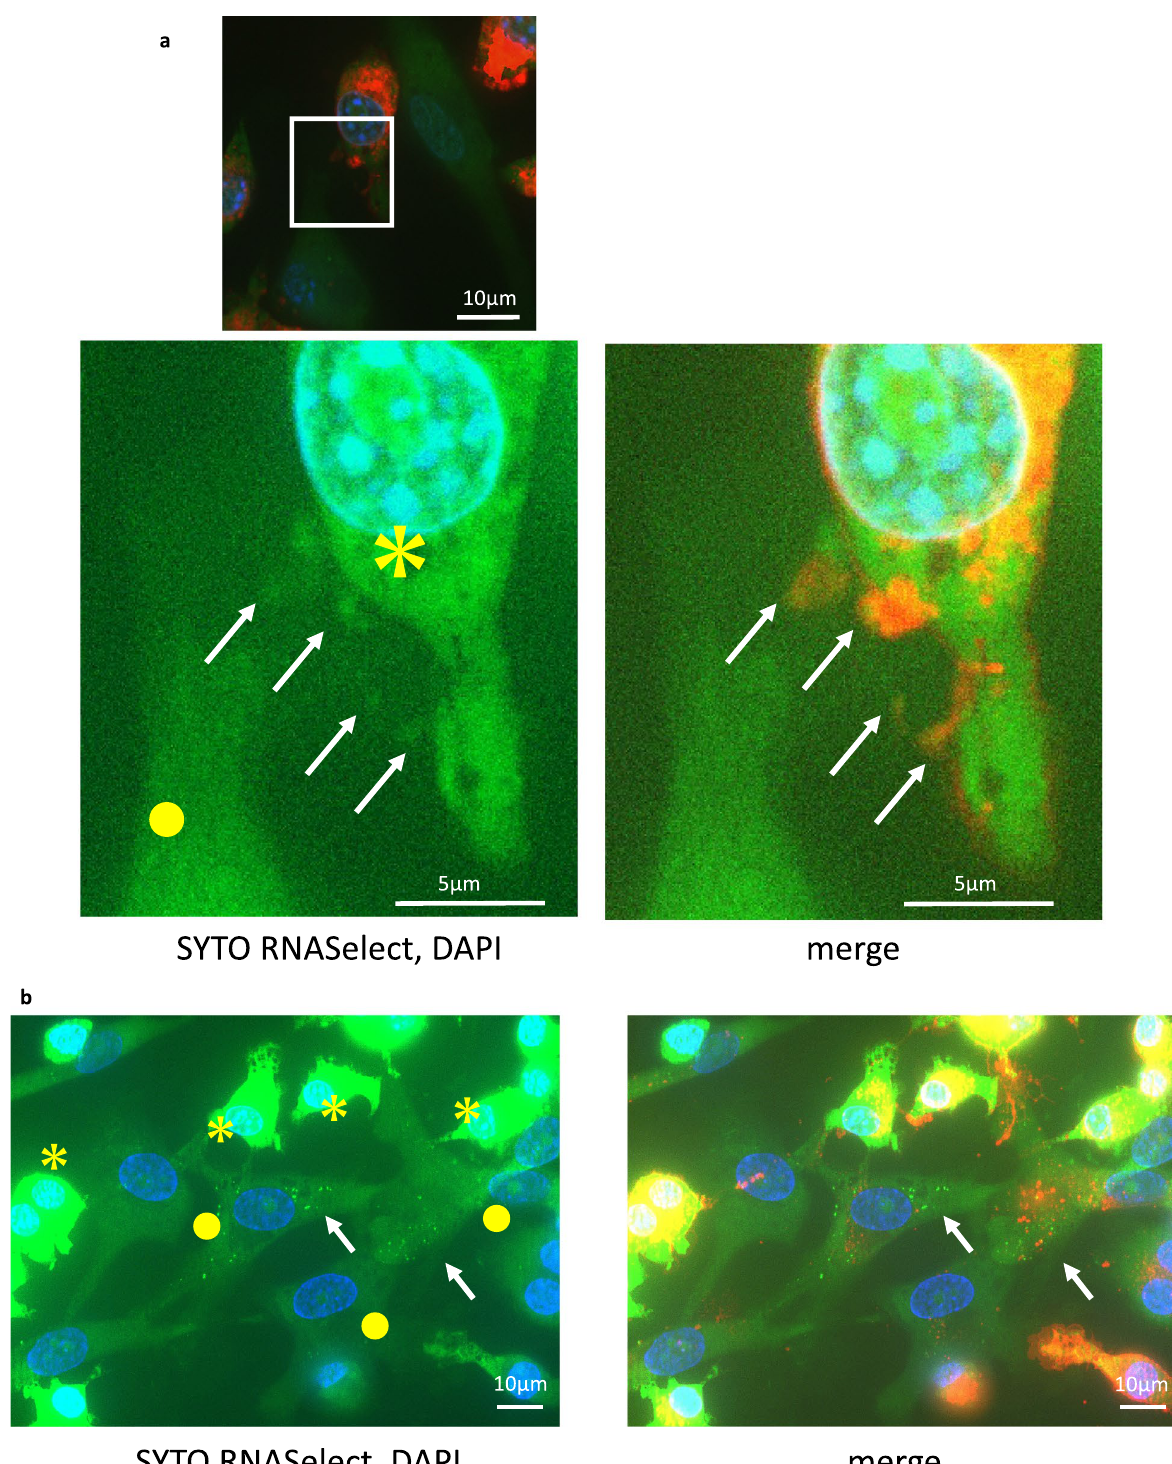
Figure 7. Tracking the cell membrane components during in vitro communication between chondrocytes and RAW264.7 cells. Red (CM-DiI): cell membrane of RAW264.7 cells, green (SYTO RNASelect): RNA from RAW264.7 cells. ( a , b ) Yellow asterisks indicate RAW264.7 cells, and yellow circles indicate chondrocytes. ( a ) Fluorescence images of cells after 4 h of coculture. SYTO RNASelect-positive points were outlined by CM-DiI (white arrow). ( b ) Fluorescence images of cells after 24 h of coculture. Chondrocytes contained RNA from RAW264.7 cells (white arrow). ( c ) Fluorescence images of four groups after 4 and 24 h of coculture. ( d ) SYTO RNASelect-positive points count per chondrocyte. The data are shown as the means ± S.D. *p < 0.001. n =